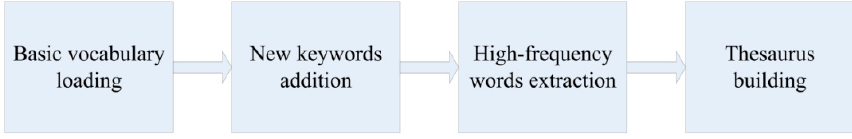
Figure 5. The process of emotional thesaurus generation with NLPIR.